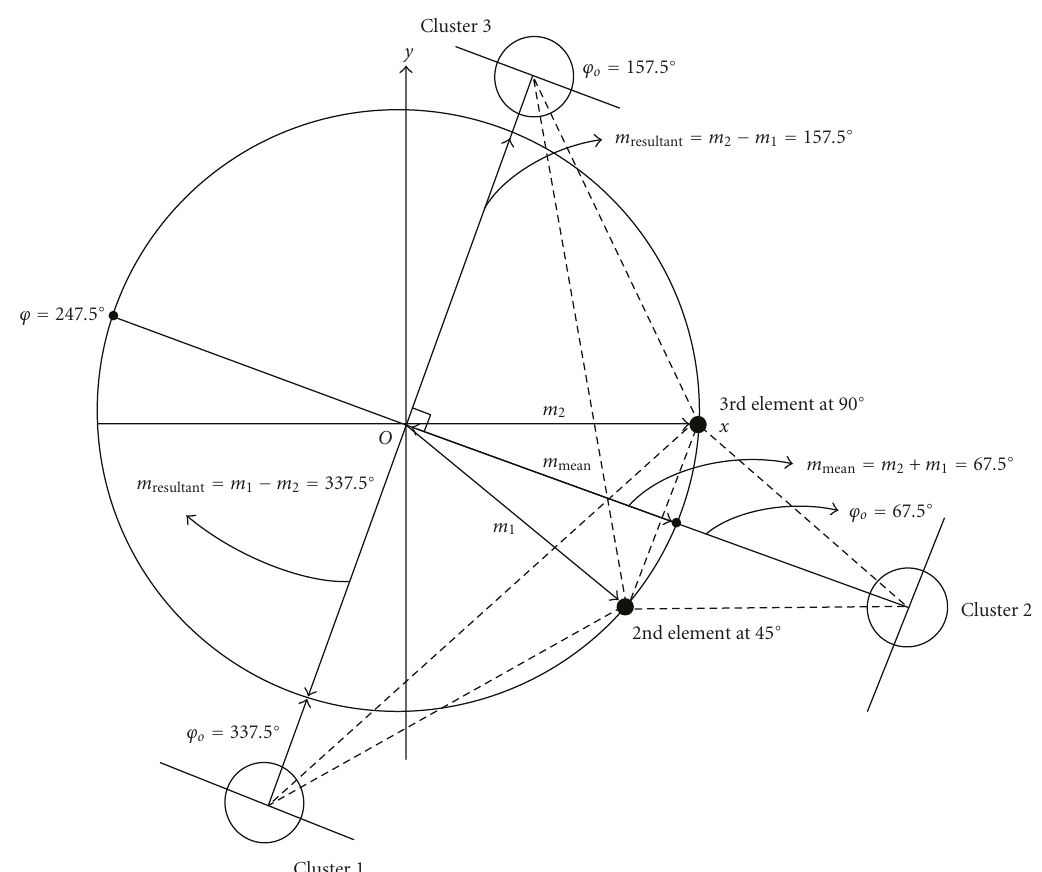
Figure 4: This figure illustrates the geometric interpretation of correlation function for the results obtained earlier.